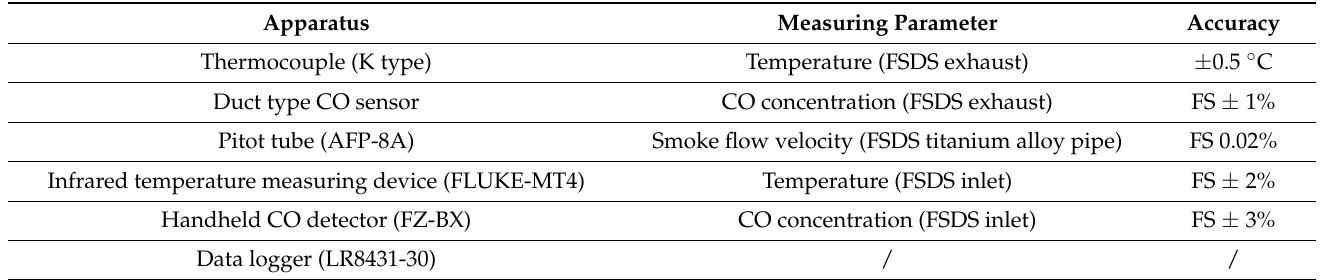
Table 3. List of the main experimental measuring apparatus.